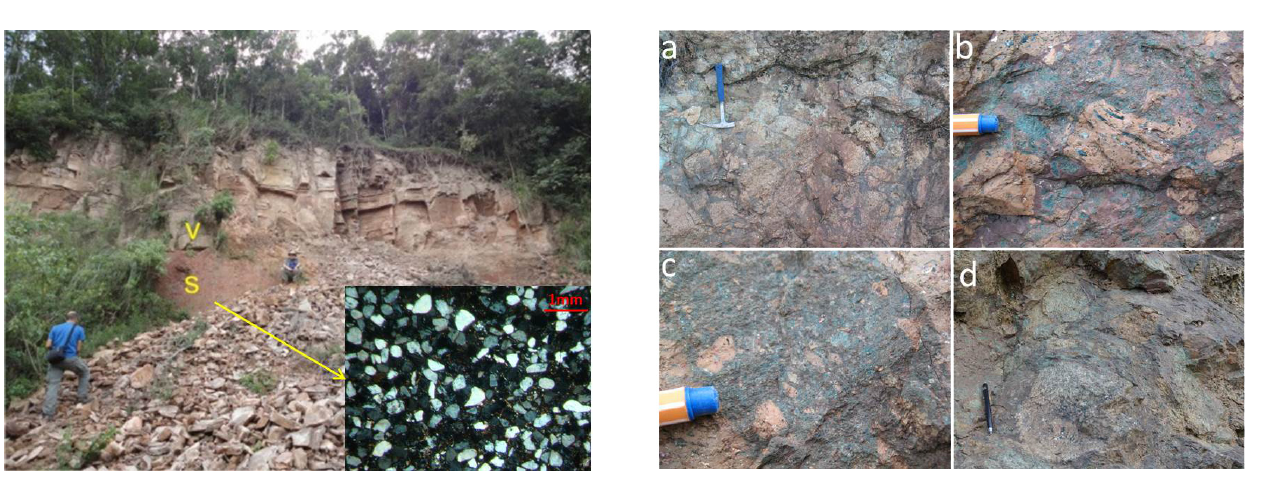
Fig. 10. Aspects of the two lowermost peperites in the Palmas vol- canic sequence, along the Rota do Sol highway (Rio Grande do Sul State): images of the lowermost peperite ( a , b , and c ) and of the middle peperite (d) . The volcanic clasts are pale and light or dark green, while the siltstone is dark brown.